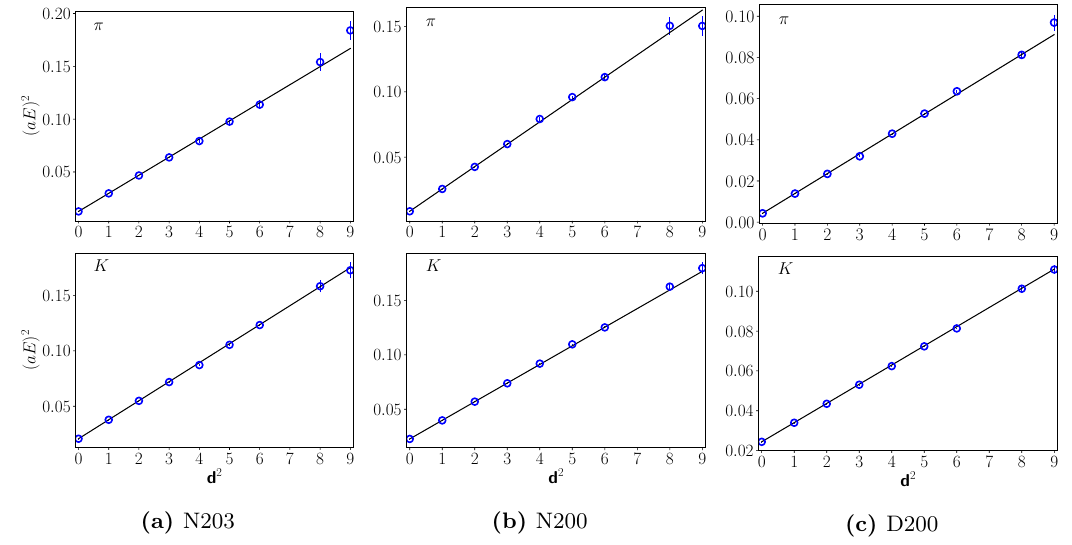
Figure 1. Single-pion (top row) and single-kaon (bottom row) energies vs. d 2 for the frames we use. The continuum dispersion relations from the energies at rest are shown as black